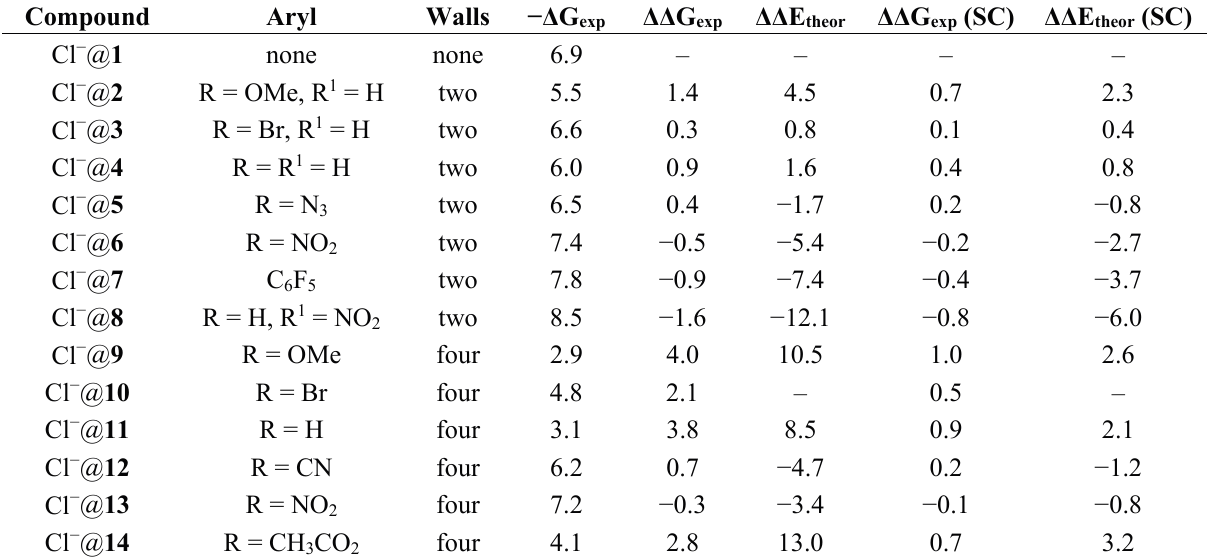
Table 1. Experimental Δ G, ΔΔ G, and theoretical ΔΔ E values in kcal/mol for the Cl − complexes of the calix[4]pyrrole receptor series. See text for details. The statistically corrected ΔΔ G(SC) and ΔΔ E(SC) values are obtained by dividing ΔΔ G and ΔΔ E by the number of receptor walls. Compound Aryl